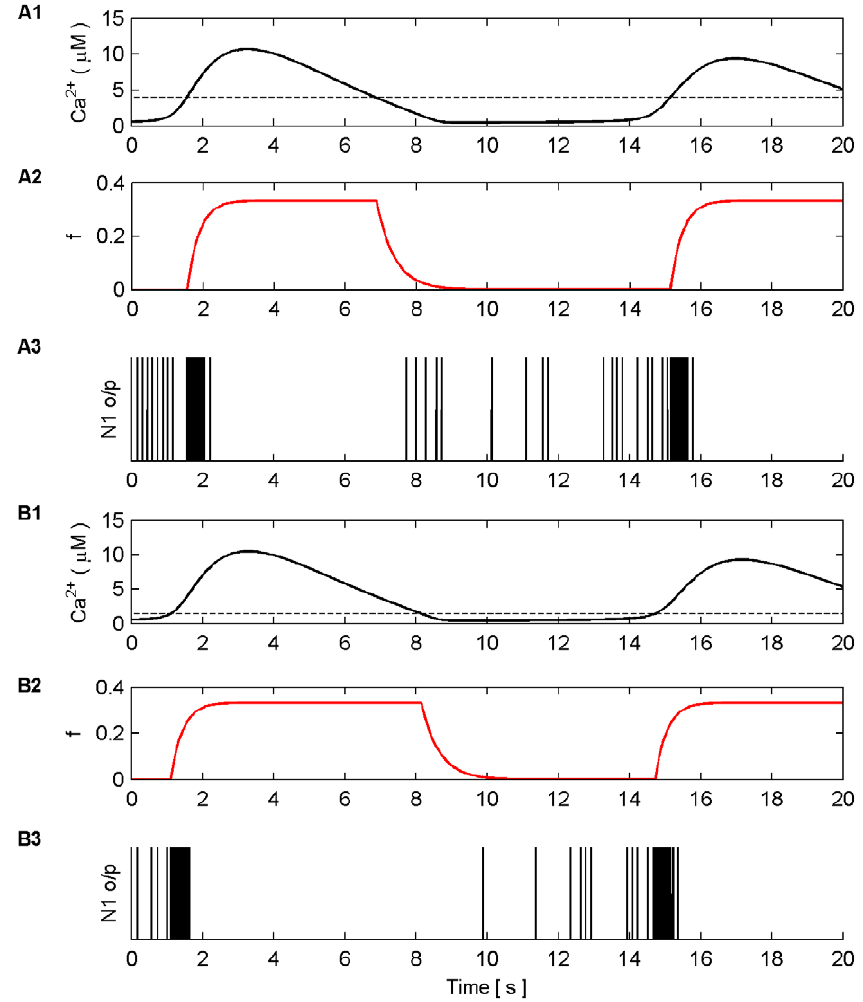
Figure 13. Threshold variations vs the onset of coordination. (A1) Total Ca 2 + level and Ca 2 + threshold (dashed line, 3.94 m M). (A2) f function. (A3) Spiking activity (o/p) of N1. (B1–B3) same as (A1–A3) with Ca 2 + threshold set at 1.44 m M. Notice how the onset of bursting and the f function is delayed when the threshold is set at 3.94 m M since more time is required for the total Ca 2 + level to cross the threshold. Furthermore, f is activated for a shorter period thereby reducing the duration of the silent period between bursts. Note that N2 bursts at the same time as N1 (data not shown).